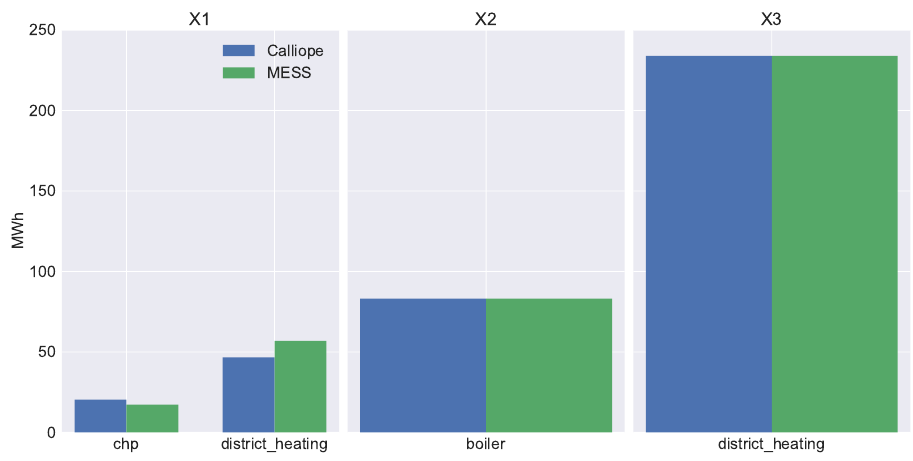
Figure 6. Annual heating per technology source—Calliope and MESS